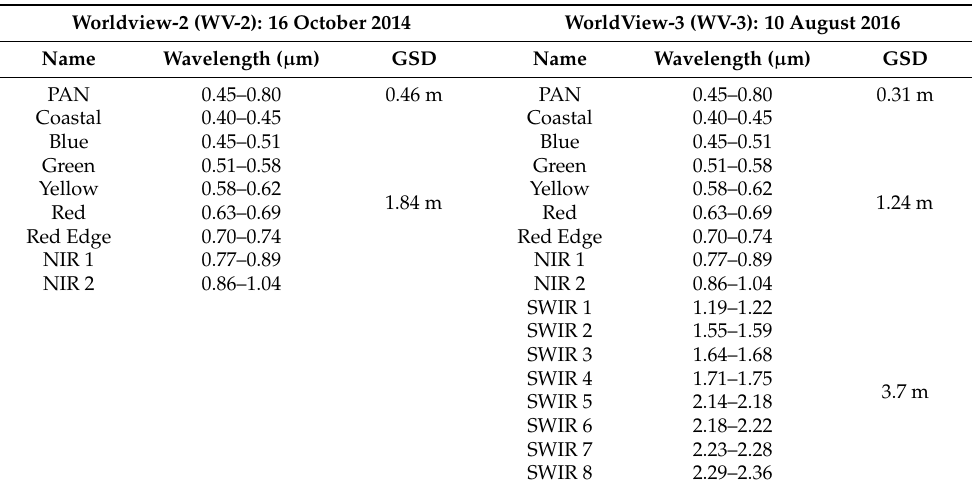
Table 1. Spectral band names, wavelength ranges, ground sampling distances (GSD), and acquisition dates of the primary images of the current